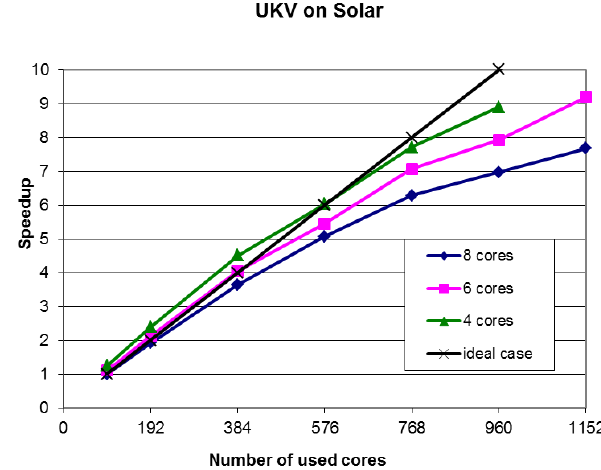
Figure 5. Speedup as a function of number of used cores on Solar. Speedup was calculated in relation to the elapsed time of 11488s obtained for a 96-core run on fully committed